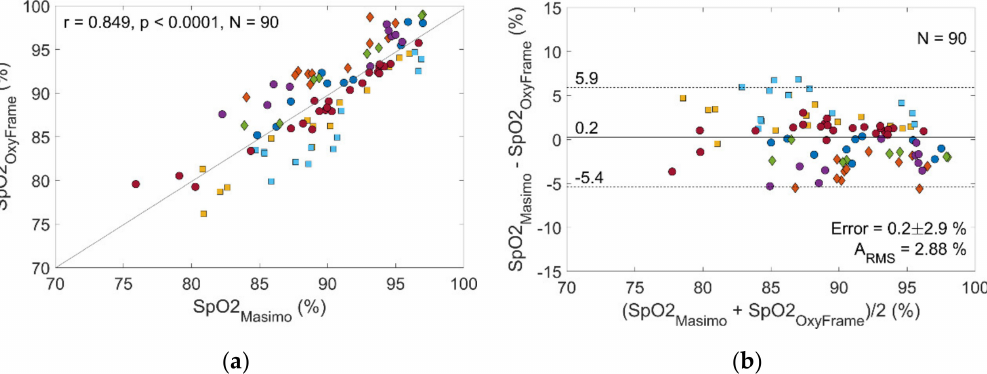
Figure 4. Performance of the OxyFrame device compared to a standard sensor (MASIMO) in healthy volunteers. ( a ) Correlation plot S p O 2 measurement by OxyFrame versus MASIMO. ( b ) Bland-Altman plot S p O 2 measurement by OxyFrame versus MASIMO. Measurements of the same volunteer have the same color and